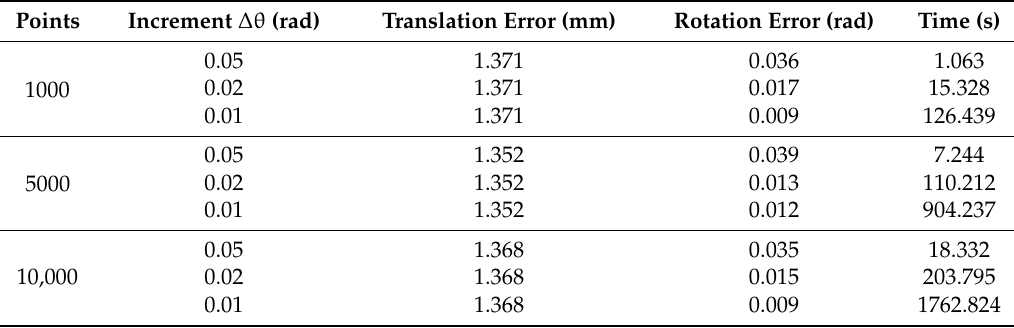
Table 1. Experimental results using the connector model obtained by the proposed coarse registration method with different samplings and increments ∆ θ .